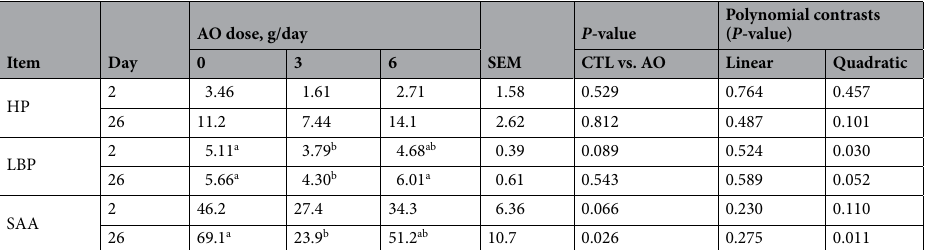
Polynomial contrasts ( P -value)